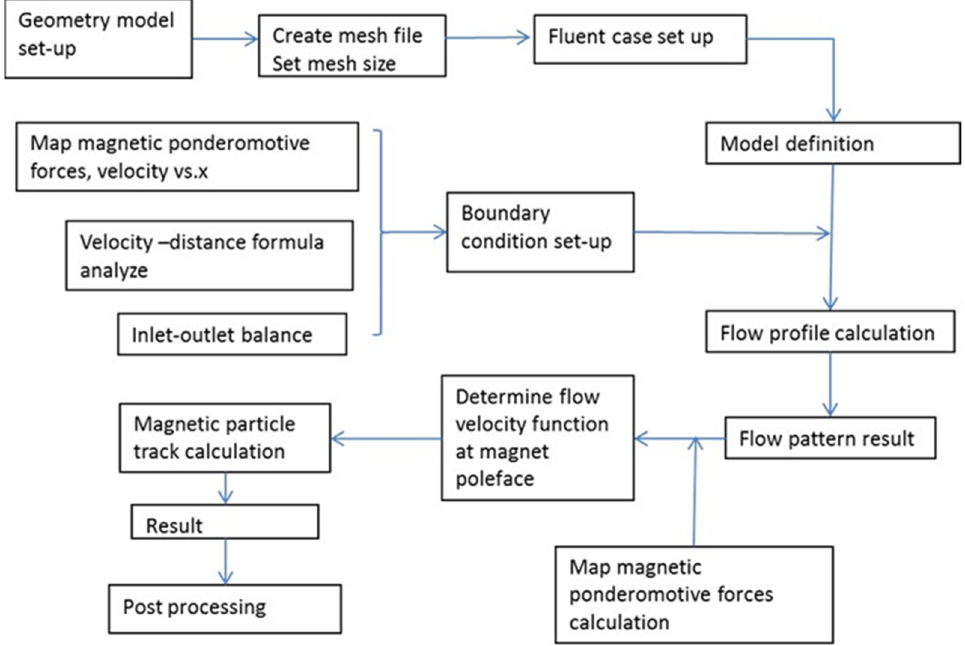
Figure 3. Flow chart for CFD simulation showing the blend of ICEM, FLUENT and user-defined analytical functions. analytical